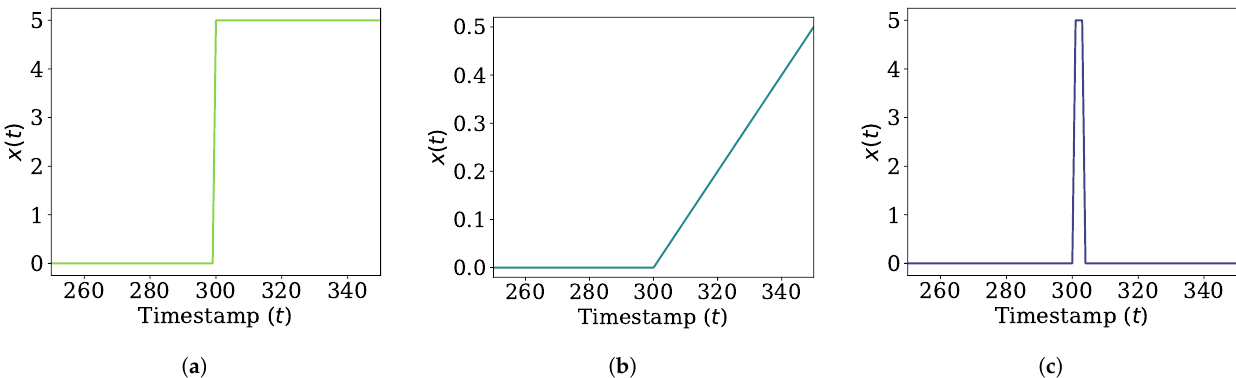
Figure 3. Changes in mean of distributions for data streams where concept drift occurs. ( a ) Sudden concept drift. ( b ) Incremental concept drift. ( c ) Blip concept